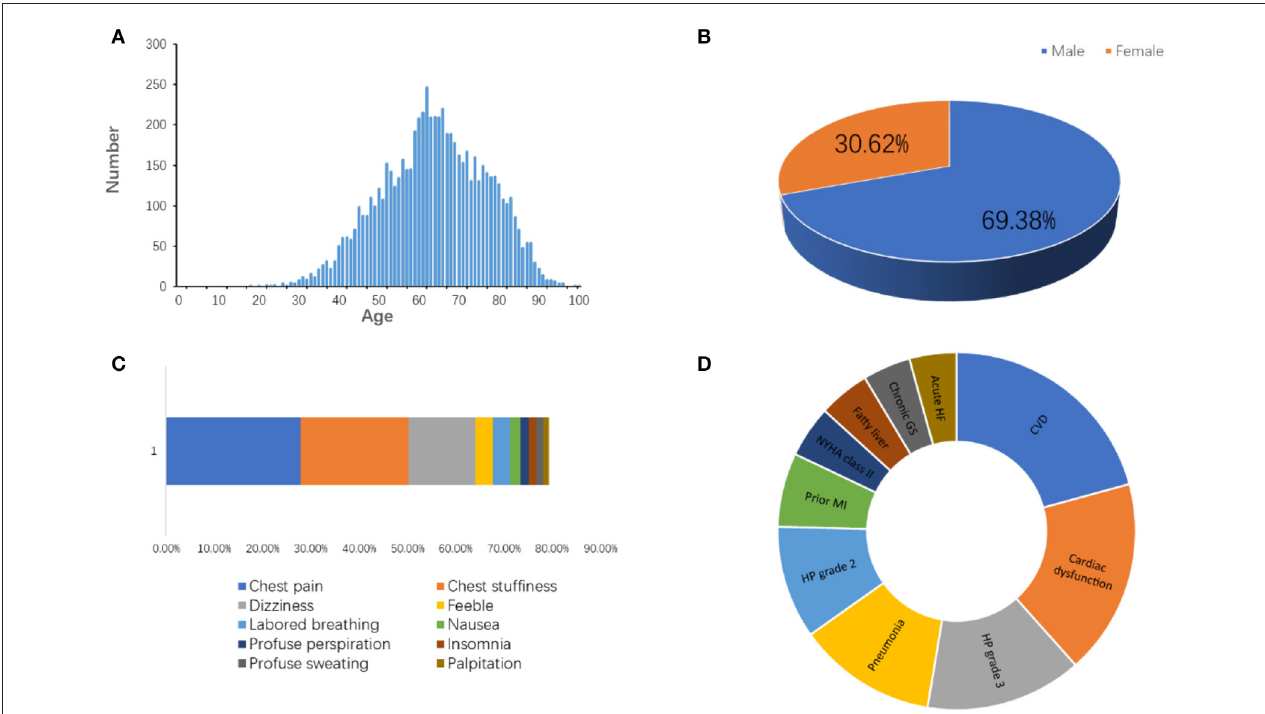
FIGURE 3 | The information of patients diagnosed as MI admitted to the Affiliated Hospital of Qingdao University from 2015 to 2020. (A) Age distribution. (B) Gender distribution. (C) Symptoms. (D) Companion diagnosis. CVD, cardiovascular disease; HP, high blood pressure; MI, myocardial infarction; GS, gastritis; HF, heart